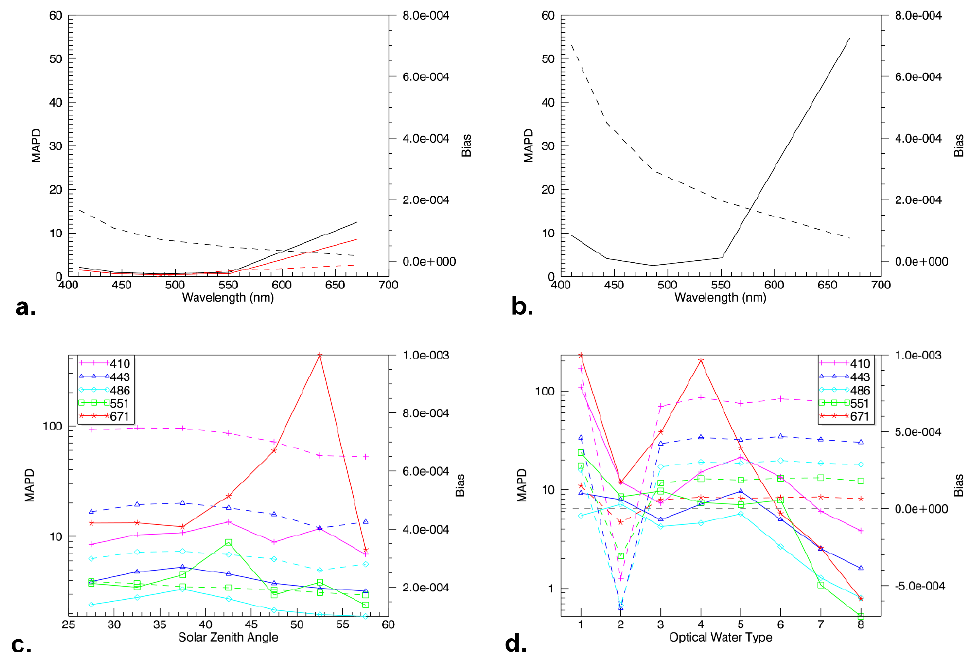
Figure 8. Sensitivity to processing parameters. ( a ) Mean Absolute Percent Difference (MAPD) and bias between R rs calculated with wind speed of 1 ms ´ 1 (black lines) and 5 ms ´ 1 (red lines) relative to R rs calculated with wind speed of 3 ms ´ 1 ; ( b ) MAPD and bias between R rs calculated with M15 and M99; ( c ) MAPD and bias between R rs calculated with M15 and M99 classified by sun zenith angle; ( d ) MAPD and bias between R rs calculated with M15 and M99 classified by optical water types (OWTs). In all cases MAPD is shown as solid lines and left axis while Bias is shown as dashed lines and right axis; c. and d. use log scale for